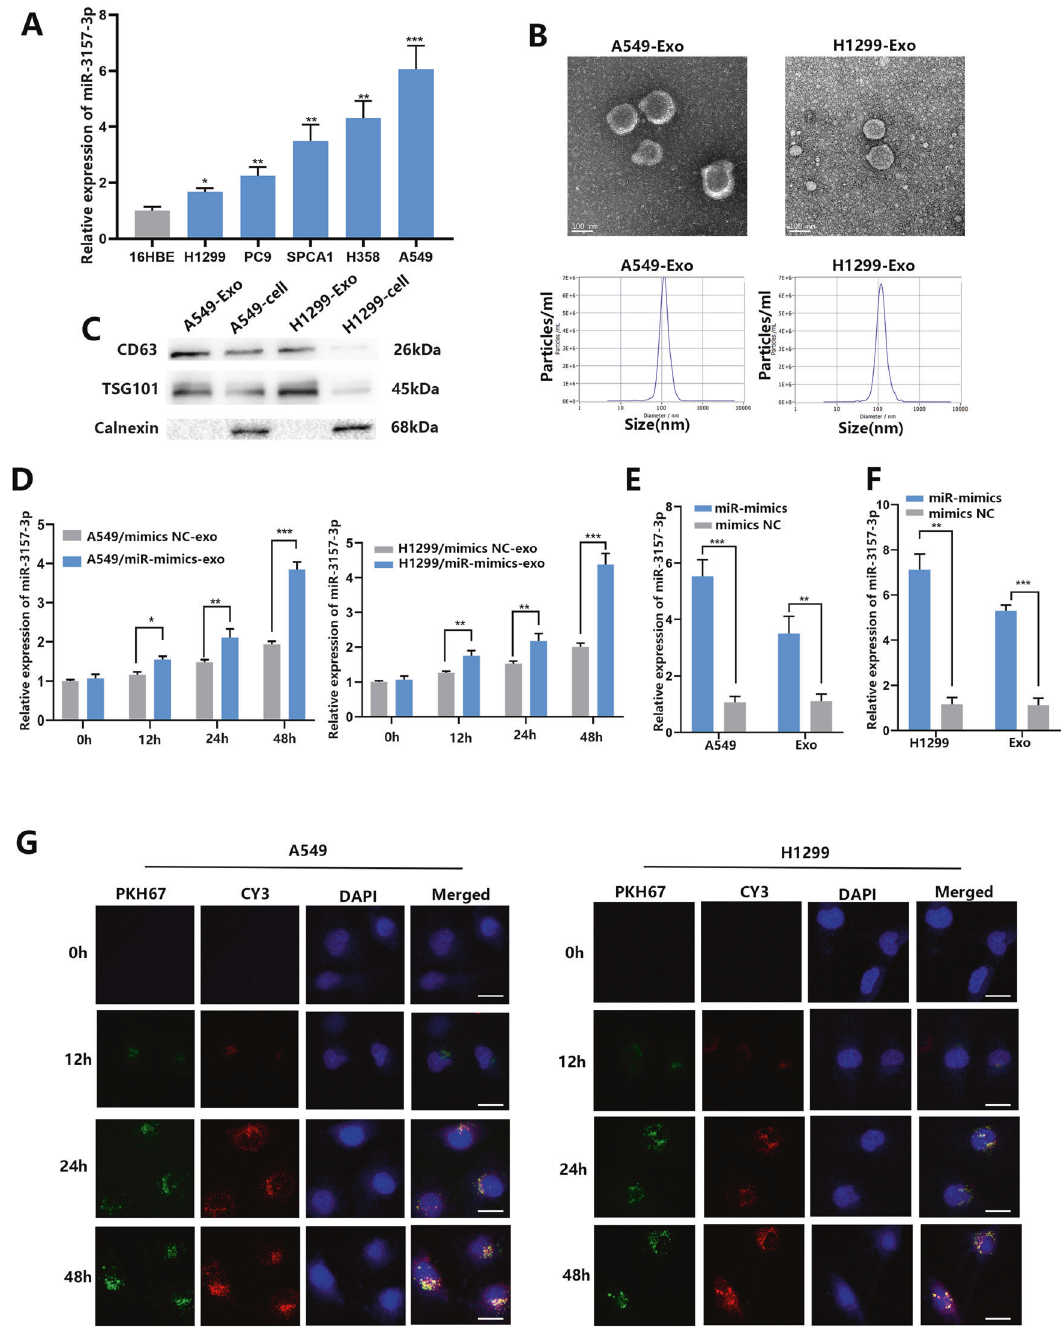
Fig. 2 NSCLC-secreted miR-3157-3p is transferred to HUVECS. A NSCLC cell lines miR-3157-3p levels were analyzed using qRT-PCR. B Representative electron microscopy micrographs and NTA of A549 conditioning medium secreted exosomes, as well as H1299 conditioning medium secreted exosomes. Scale bar, 100 nm. C CD63, TSG101, and calnexin were determined by western blot. D qRT-PCR analysis of miR- 3157-3p expression in HUVECs incubated with exosomes derived from LUAD cells for 2 h, 12 h, 24 h, and 48 h. E , F miR-3157-3p expression in A549 and H1299 transfected with miR-mimics or mimics NC) and their derived exosomes using qRT-PCR. G Cy3 fl uorescence and PKH67 lipid dye in HUVECs after adding PKH67- labeled exosomes derived from A549 and H1299 cells for 48 h. Scale bar, 20 μ m. The data are shown as the mean ± SD (* P < 0.05; ** P < 0.01; *** P <